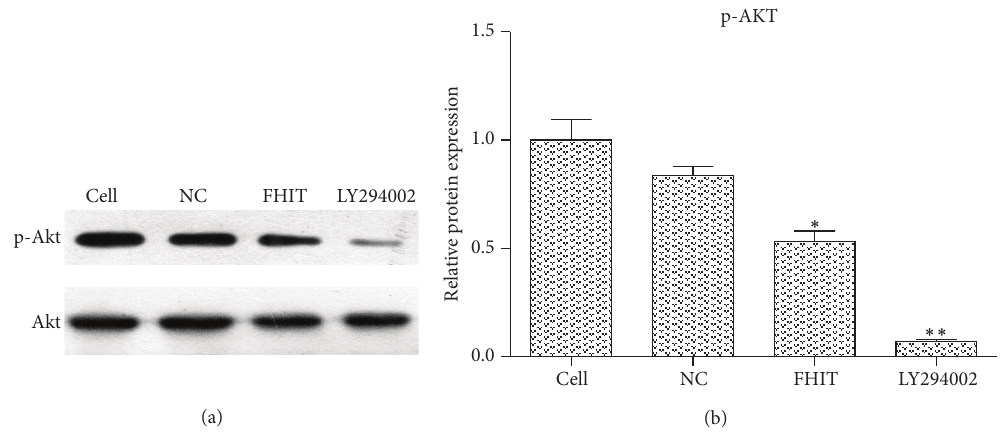
Figure 2: The levels of p-Akt were assessed by western blotting. (a) Western blotting for p-Akt. (b) Quantification of p-Akt protein levels in each group, presented in bar graphs as fold-increase. ∗ 𝑃 < 0.05 versus NC/FHIT; ∗∗ 𝑃 < 0.001 versus NC/LY294002.